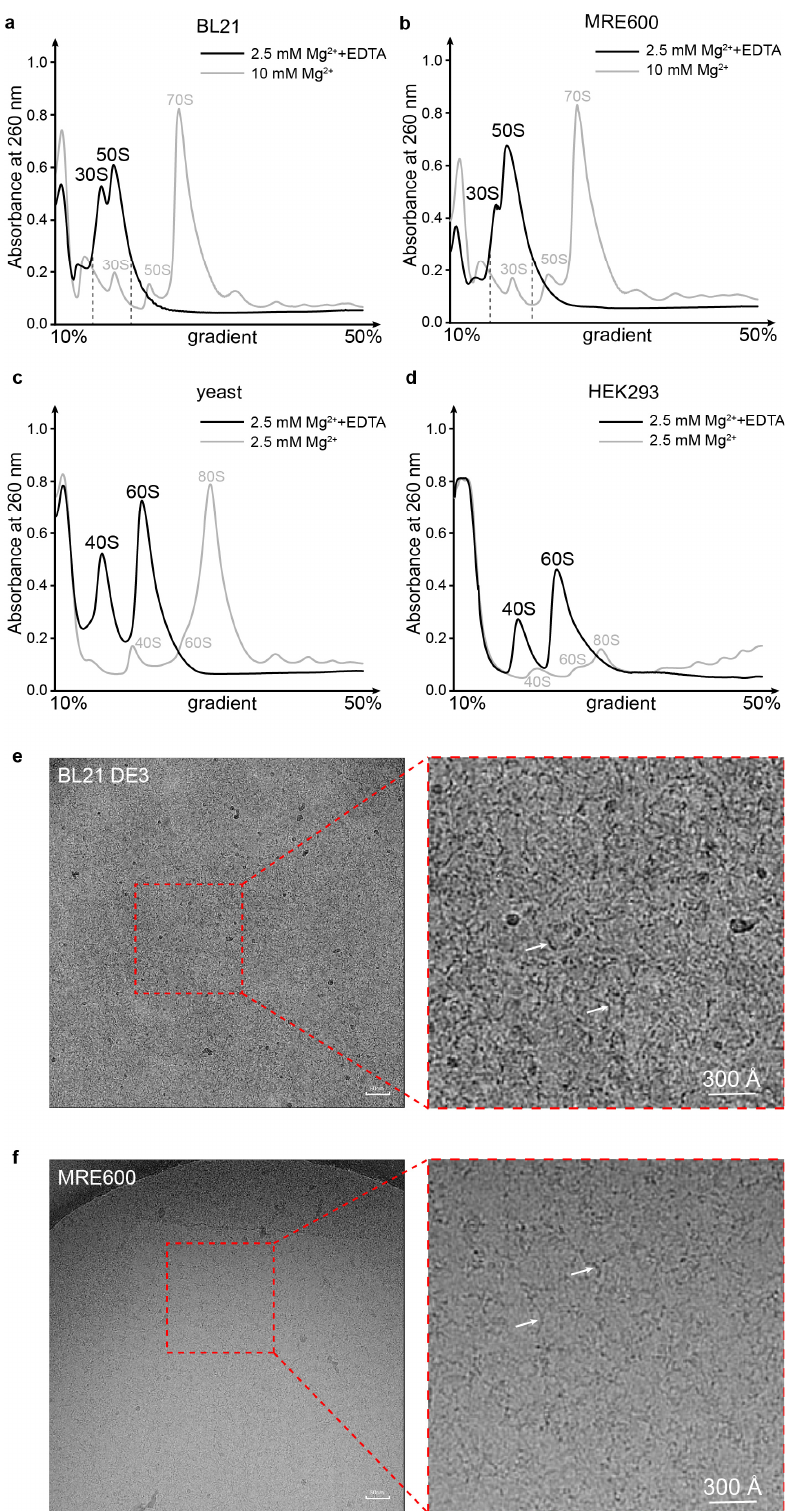
Figure 1. Subunits of the 70S ribosome were destroyed by EDTA. ( a , b ) E. coli cells of the BL21 DE3 ( a ) and MRE600 ( b ) strains were collected at OD 600 = 0.6 and further analyzed with a sucrose gradient in conditions with or without 10 mM EDTA. Shifting of the peaks was indicated, and the 30S and 50S peaks from the gradient with additional EDTA were collected (dashed line labeled) for cryoEM analysis. ( c , d ) Yeast BY4742 cells ( c ) and HEK293F cells ( d ) grown to exponential phase were col- lected and disrupted by a French press and homogenizer, respectively. Cell extracts were then ana- lyzed with a sucrose gradient under conditions of 2.5 mM Mg 2+ or 10 mM EDTA. ( e , f ) CryoEM